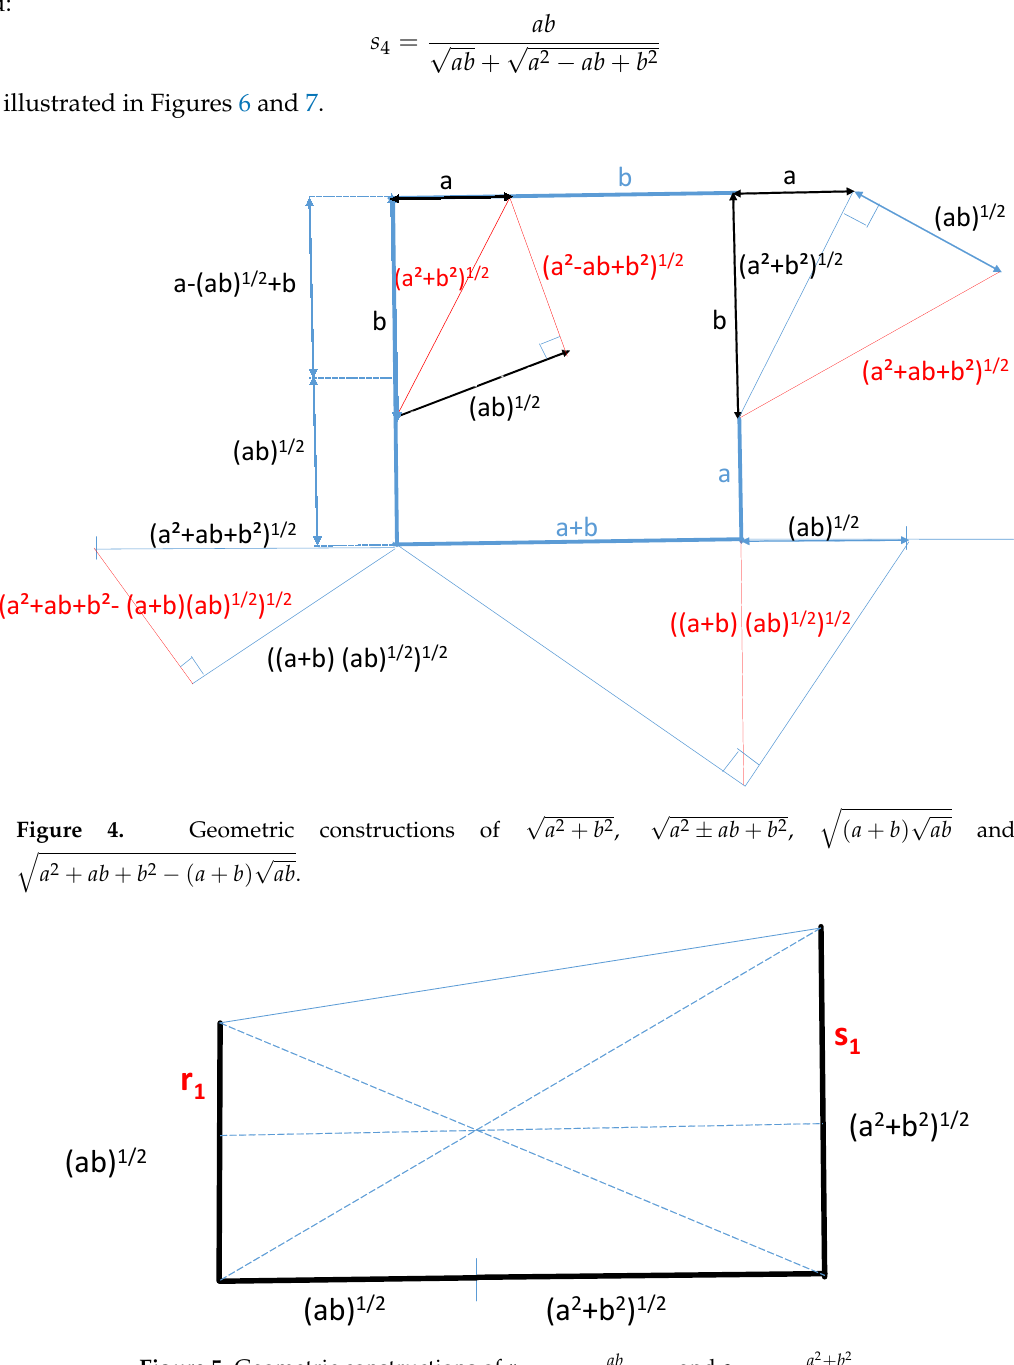
Figure 5. Geometric constructions of r 1 = ab √